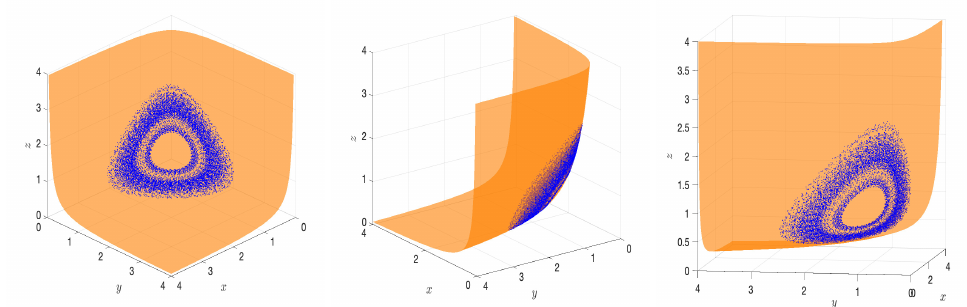
Figure 4. Phase space plot of the numerical solutions from different angels for Example 1 with h =